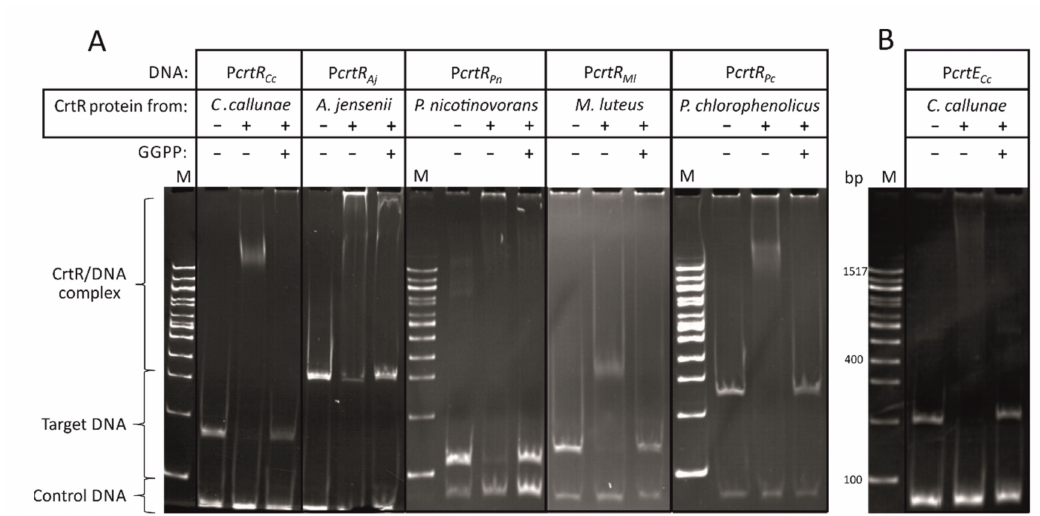
Figure 2. In vitro characterization of CrtR orthologs. ( A ) Bandshift assays of CrtR orthologs from C. callunae , A. jensenii , P. nicotinovorans , M. luteus and P. chlorophenolicus with their respective own putative promoter region and the inhibition of the binding by GGPP. ( B ) Bandshift assays of CrtR from C. callunae with a putative crtE promoter region and the inhibition of the binding by GGPP. The presense or absence of CrtR protein and GGPP are indicated by “ + ” and “ − “,